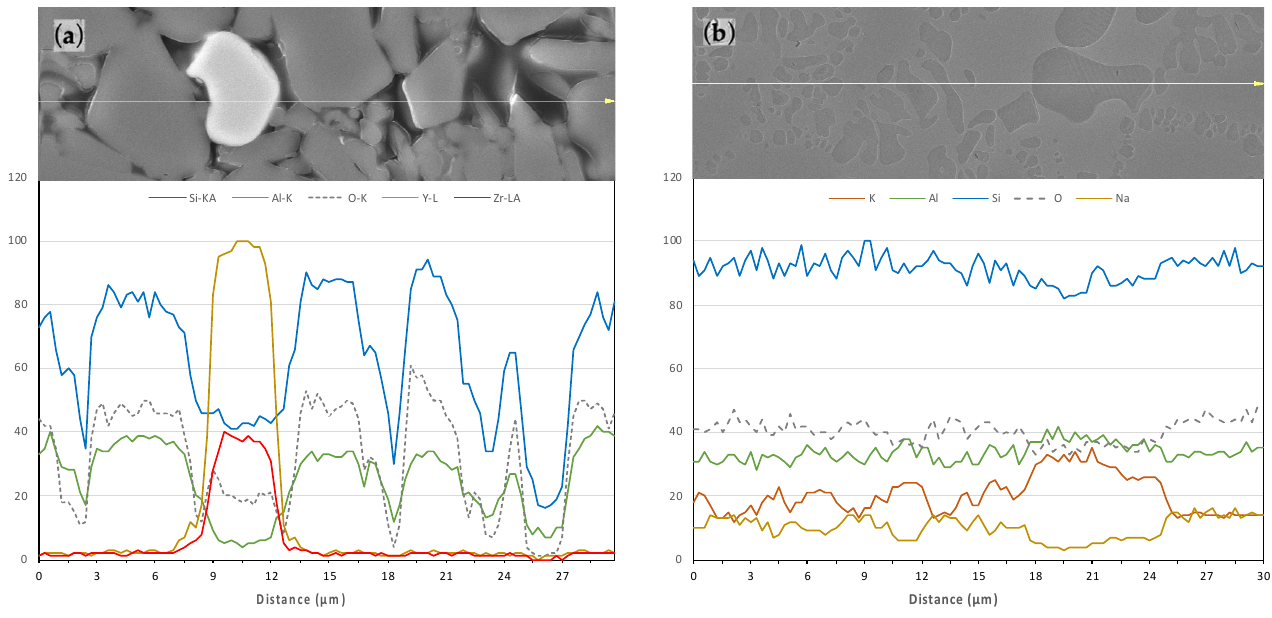
Figure 4. FESEM micrographs of polished and etched surfaces of ( a , b ) VE and ( c , d ) EC materials.